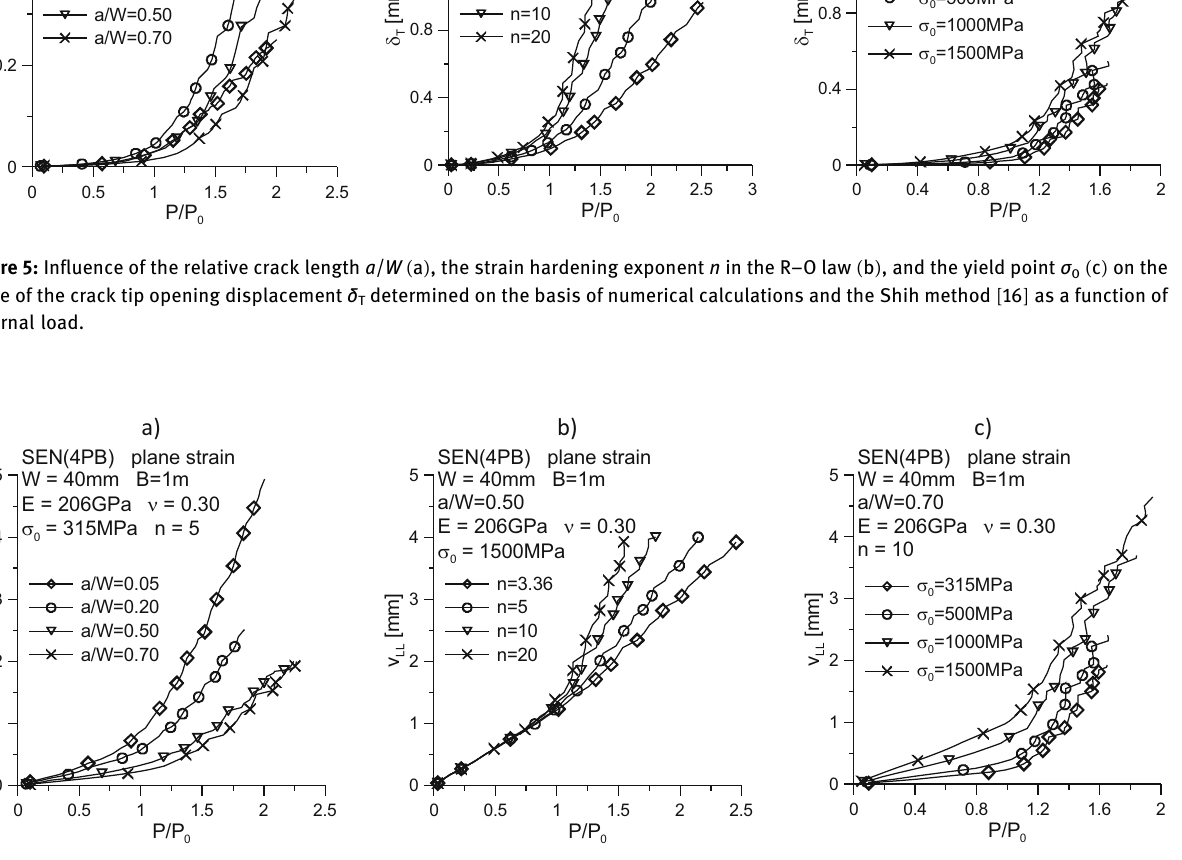
Figure 6: In fl uence of the relative crack length a / W ( a ) , the strain hardening exponent n in the R – O law ( b ) , and the yield point σ 0 ( c ) on the value of the load line displacement v LL as a function of the external load [ 31 ]